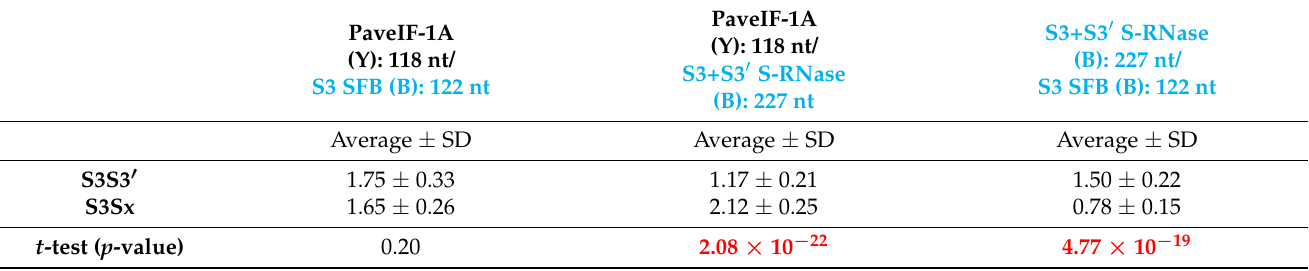
Figure 4. A representative output of fragment analysis for S3S3 (cid:48) and S1S3 as a prototype of S3Sx genotypes. Table 4. A comparison of S3S3 (cid:48) and S3Sx genotypes. Ratios of respective peak heights were calculated and compared. The letter in parentheses indicates the channel a specific peak is detected in Y yellow (represented here by black for contrast); B blue. SD: standard deviation.